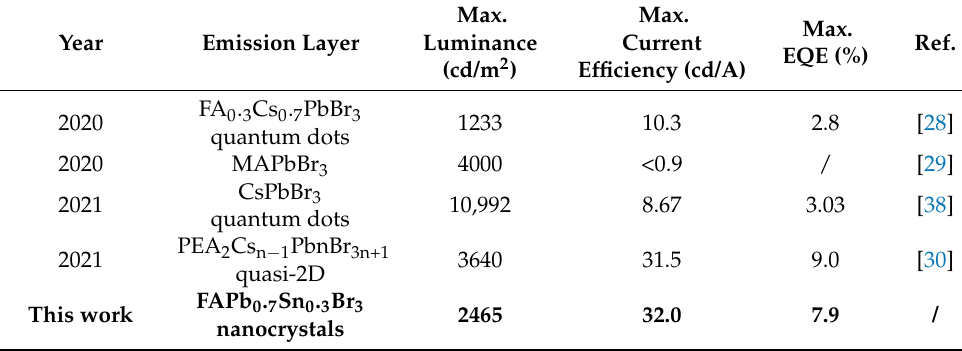
Table 4. Summary of inkjet-printed PeLEDs device